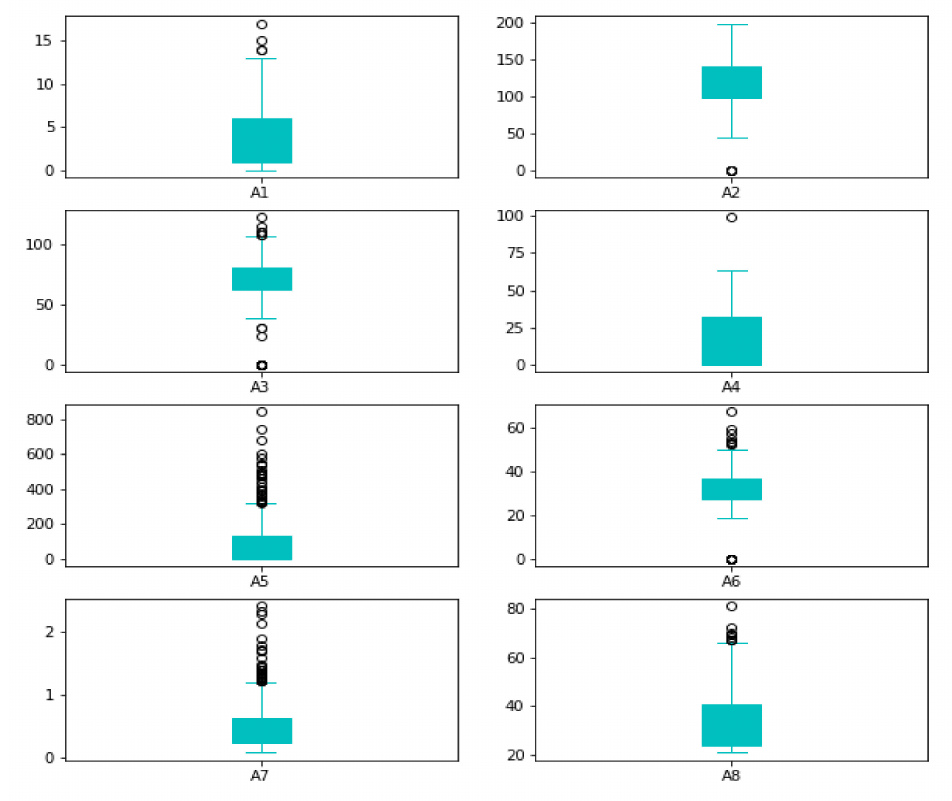
Figure 3. Boxplot showing features (A1, A2, . . . , A8) and